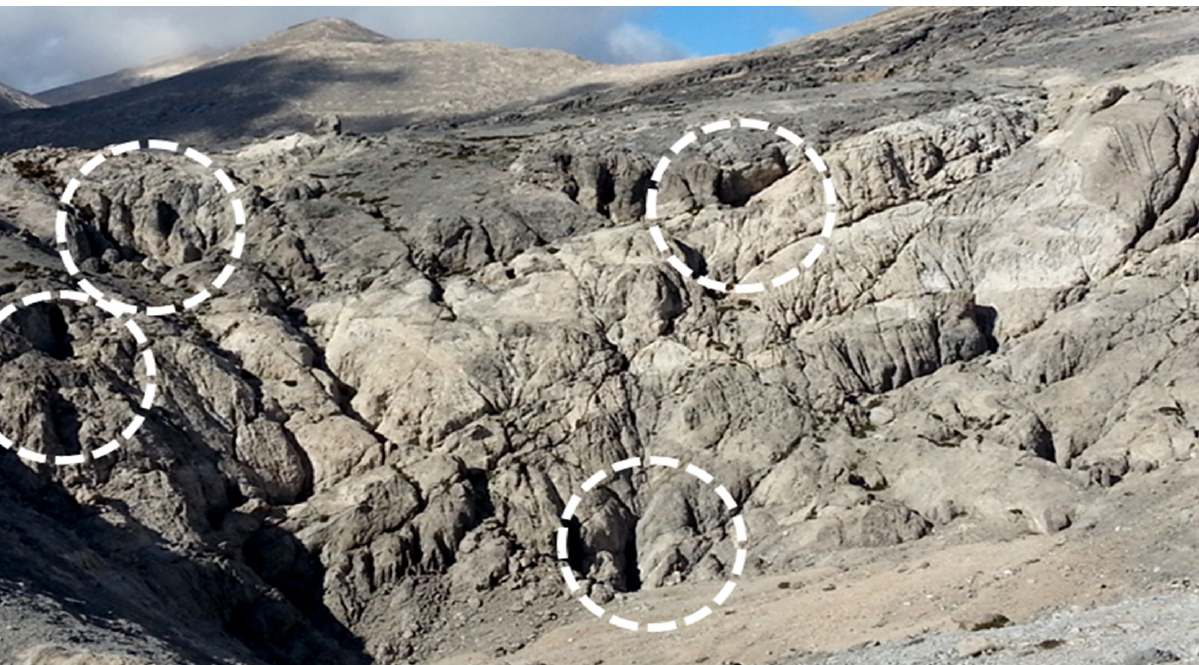
Figure 9. Karst landscape which dominates in the Central “Lefka Ori” Mountains’ area at altitudes +2000 m. It consists of black and dark gray dolomites. As was proven by References [14,37], these geological formations present an enormous karstification, which contributes to the creation of a wide variety of karst structures, namely dolines, caves and karst potholes, through which all the melted snow and rainwater penetrates, enriching the underground aquifers (photo by Pavlaki Aik.). Regarding the underlying “Plattenkalk” system, there have also been recorded lo- cal appearances of low metamorphic layers, mainly consisting of yellowish-white clays, gypsum, brown schist, as well as of well bedded crystalline limestone [21,45]. The “Tripalion unit” (Trip, Triassic-later) is clearly thrusting on the “Plattenkalk unit”, and it consists of carbonate rocks (Figure 8c). It presents two different and dis- tinct lithophases which led to their corresponding division into the lower layers and the medium–upper ones [18,19,37,46]. The lower layers are similar to those of “Plattenkalk unit”, and they consist of well- bedded gleaming white-gray marbles, with the difference being that they have not included cherts. These layers evolved through lateral lithophases’ transitions to the medium–upper and strong tectonized layers, which consist of thick bedded to unbedded crystalline car- bonate rocks. They include white limestone and black dolomite (Figure 8c), as well as black cellular dolomite and carbonate breccia-conglomerate, the pebbles’ and breccias’ of which originate from the geological formations of the “Plattenkalk unit” and its underling system [18]. Finally, in the plateaus’ areas and in the southern region, especially in the Fragokastello area, the Neocene and Quaternary sediments have been deposited from Pliocene, including marls, conglomerate, sandstone, lays and